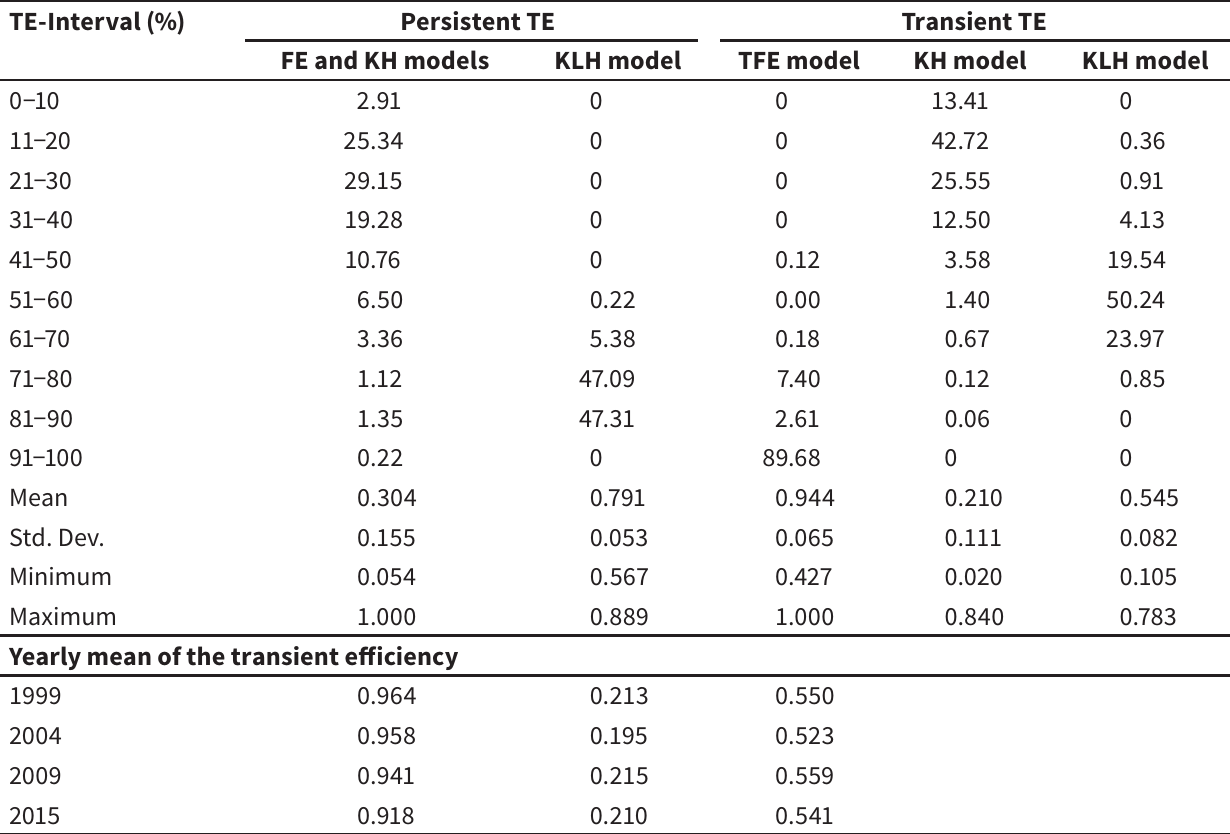
Frequency distribution of persistent and transient TEs TE-Interval (%) Persistent